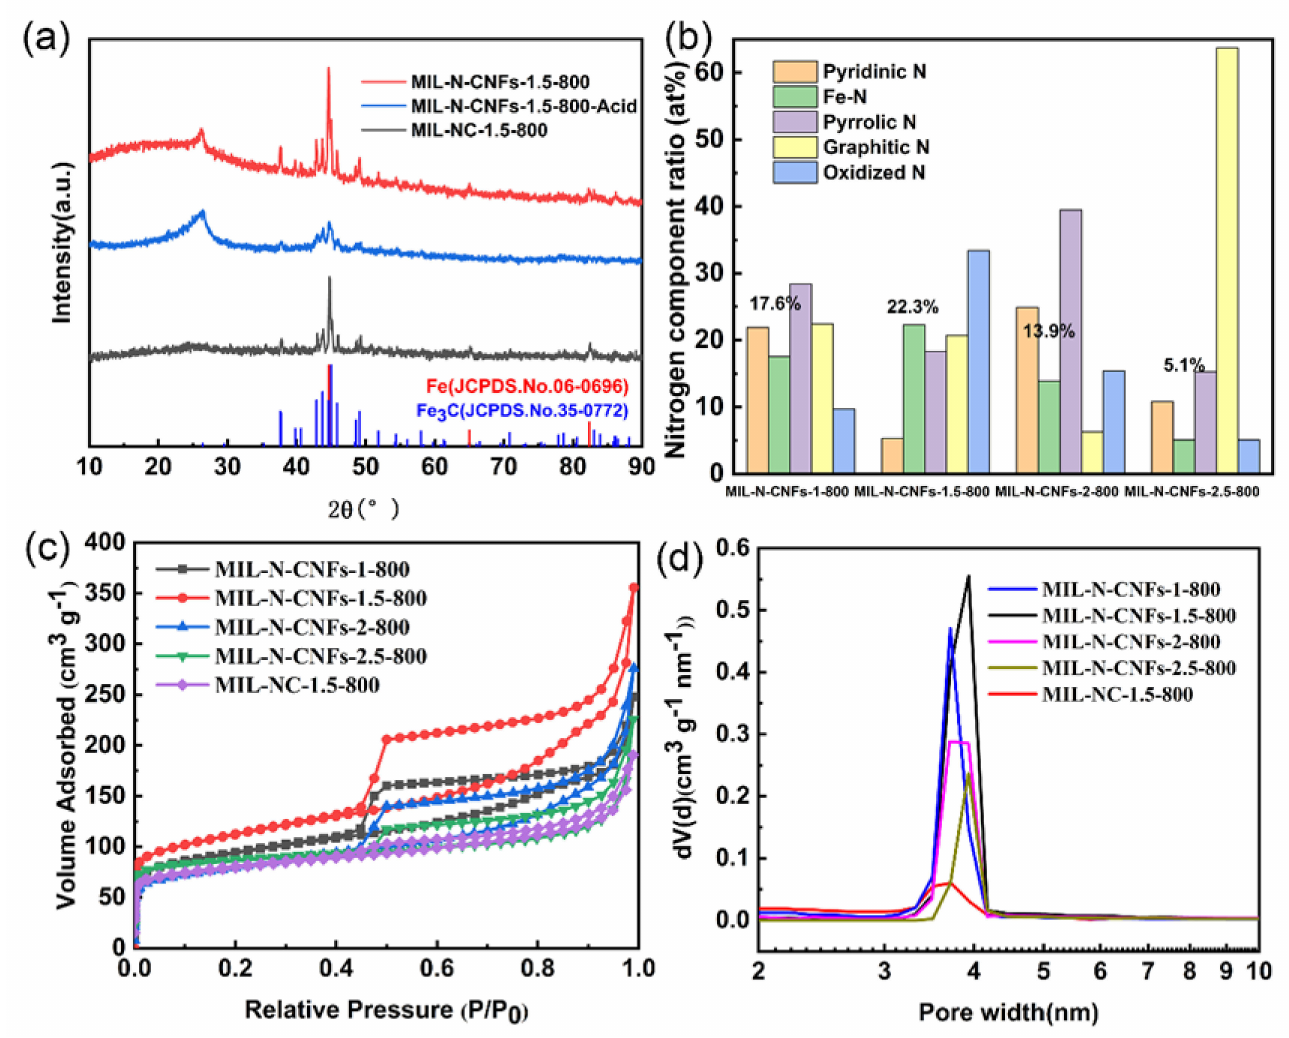
Figure 3. ( a ) XRD patterns of the catalysts MIL-N-CNFs-1.5-800, MIL-N-CNFs-1.5-800-Acid and MIL-NC-1.5-800. ( b ) Content of Pyridinic N, Fe-N, Pyrrolic N, Graphitic N and Oxidized N of MIL-N-CNFs-x-800 catalysts. ( c ) N 2 adsorption–desorption isotherm of MIL-N-CNFs-x-800s and MIL-NC-1.5-800 at 77 K and ( d ) the corresponding pore size distribution curve of MIL-N-CNFs-x-800s and